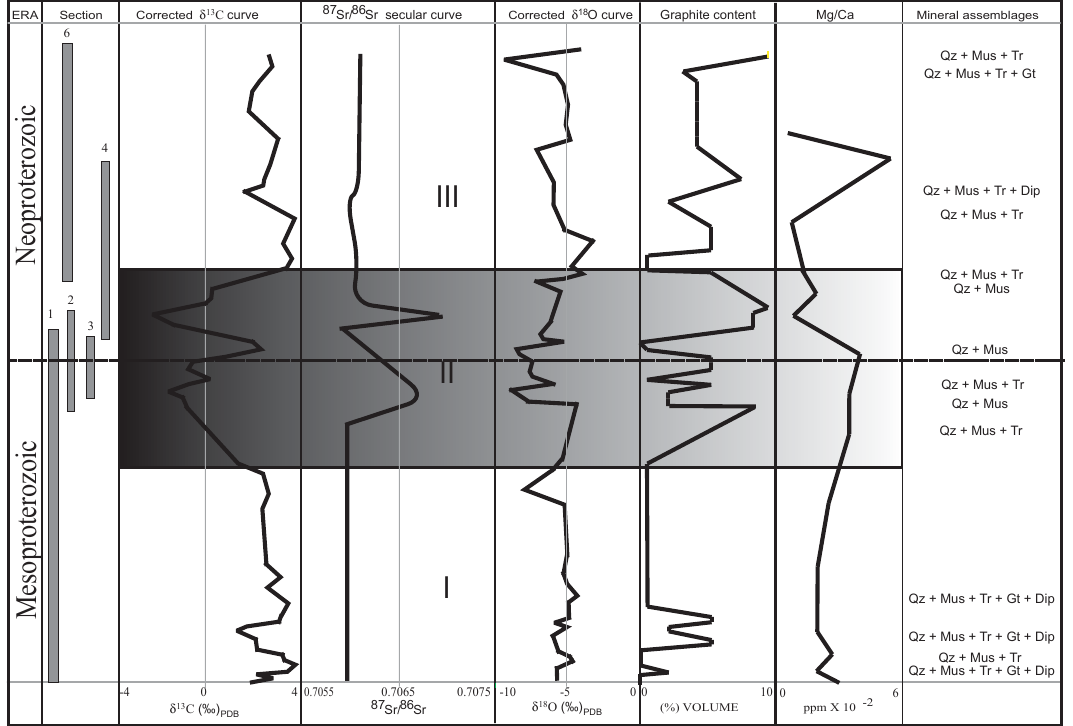
Fig. 6 – C-, Sr- and O- isotope composed chemostratigraphic curve of the São Caetano marble successions. Roman numbers represent the C-isotope stages 1, 2 and 3 identified in this study. Perturbations in the 87 Sr/ 86 Sr secular variation curve are coincident with perturbations in the δ 13 C secular variation curve. No correlation is observed between changes in silicate mineral assemblages and changes in the isotope curves. Special attention is drawn on the opposite behavior between the graphite content and the δ 13 C secular variation curves. In the left most column numbers represent the studied stratigraphic sections: 1. Pedra de Cal, 2. Malutagem, 3. Sitio dos Nunes, 4. Rodiador, 5. Santa Rosa. In the right column quartz (Qz), muscovite (Mus), tremolite (Tr), diopside (Dip), garnet